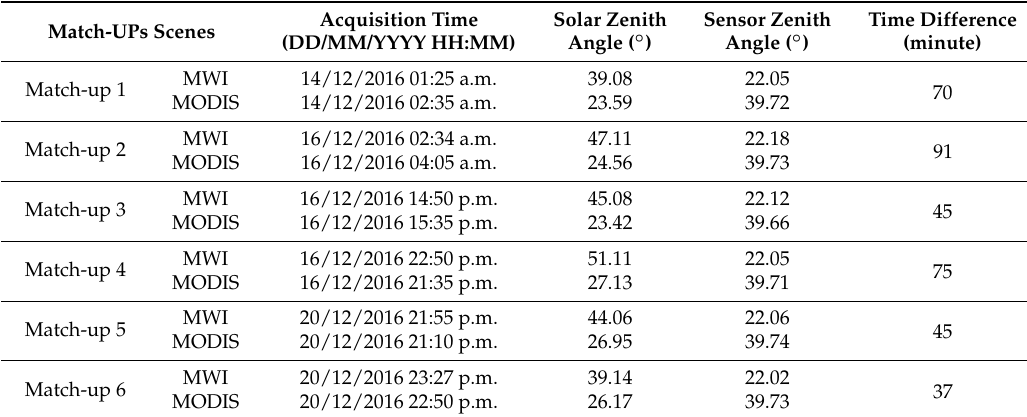
Table 2. Acquisition Times and imaging angles of MWI and MODIS match-ups (Greenwich Mean Time). Match-UPs